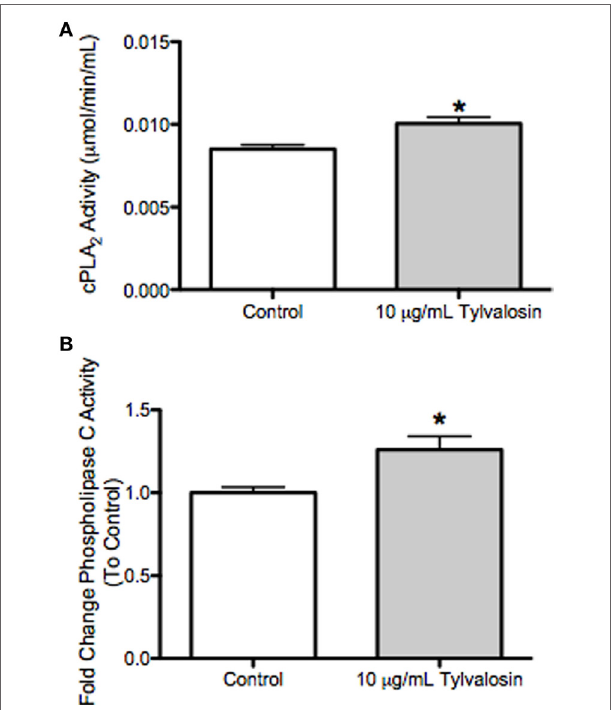
FigUre 8 | Tylvalosin increases intracellular phospholipase C (PLC) activity in porcine neutrophils. (a) Activity of cytosolic phospholipase A 2 (cPLA 2 ) was not different in cell lysates treated with tylvalosin (10 μ g/mL for 0.5 h) versus control cells given 10% HI-FBS in HBSS. Values represent cPLA 2 enzymatic activity in μ mol/min/mL. Data represent mean ± SEM (n = 5/group). * P < 0.05 versus control. (B) Activity of intracellular PLC was significantly increased in cell lysates treated with tylvalosin (10 μ g/mL for 0.5 h) versus Control cells given 10% HI-FBS in HBSS. Values represent enzymatic activity for PLC as a fold change ratio to control. Data represent mean ± SEM ( n = 4/group). * P < 0.05 versus